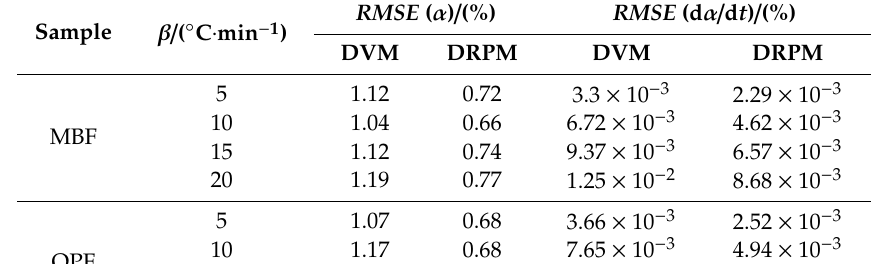
Table 7. Deviation between the experimental and calculated curves.